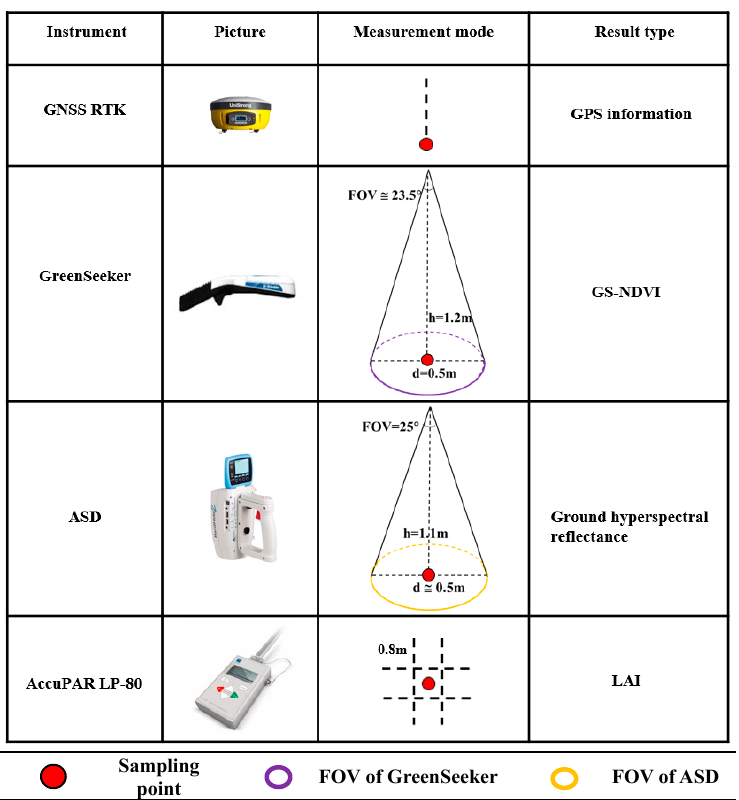
Figure 3. Measurement mode of field-based sensors.